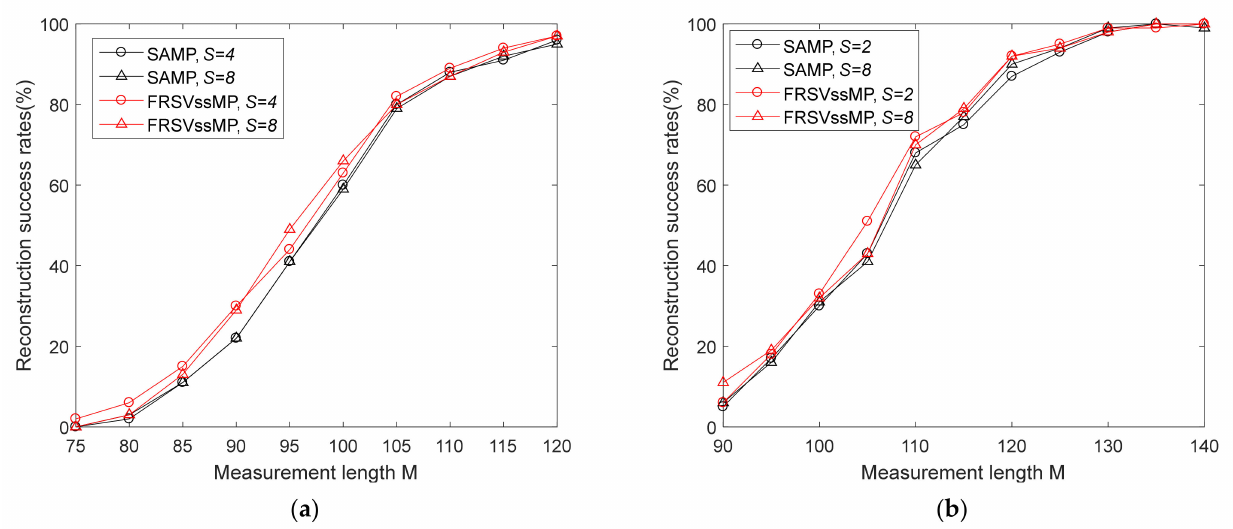
Figure 10. Reconstruction success rates vs. variable step sizes. ( a ) Synthetic signals; ( b ) Real